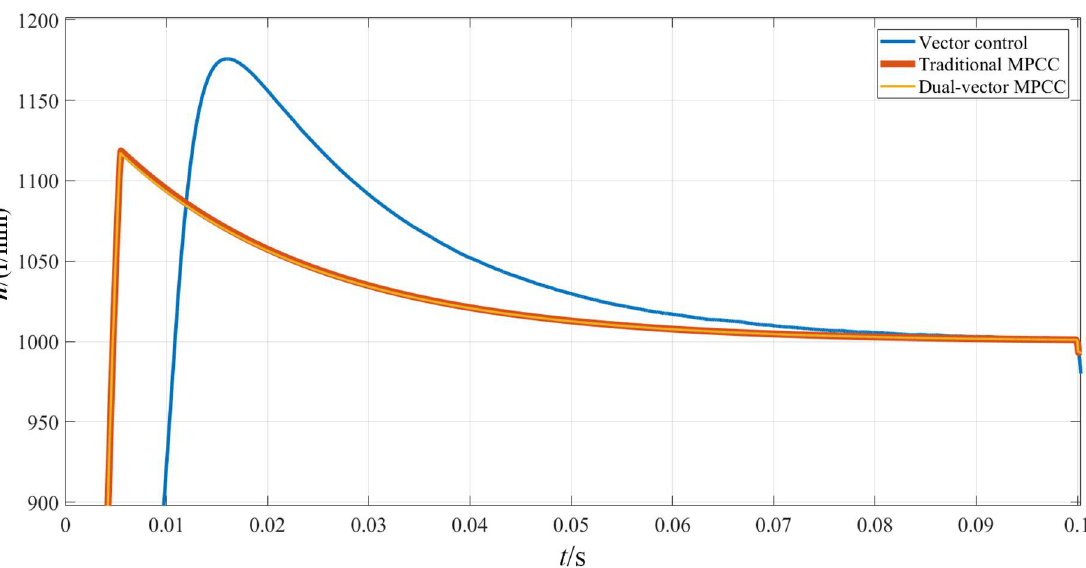
Fig 7. Rotational speed waveform when the motor